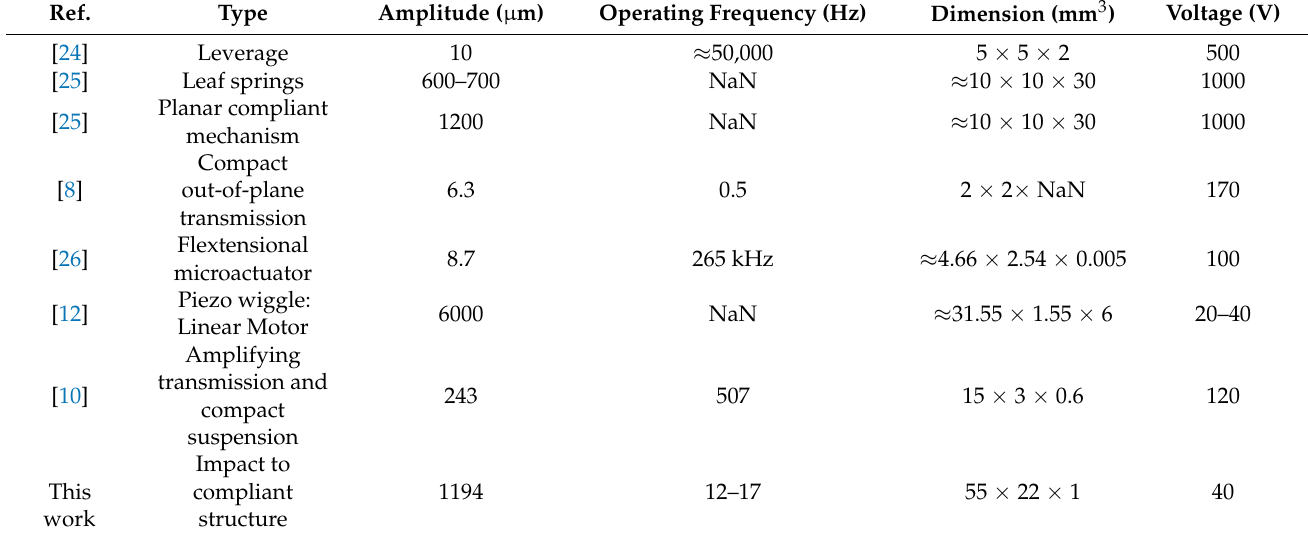
Table 3. Features of previously reported piezoelectric amplification mechanisms at millimeter–centimeter scales.